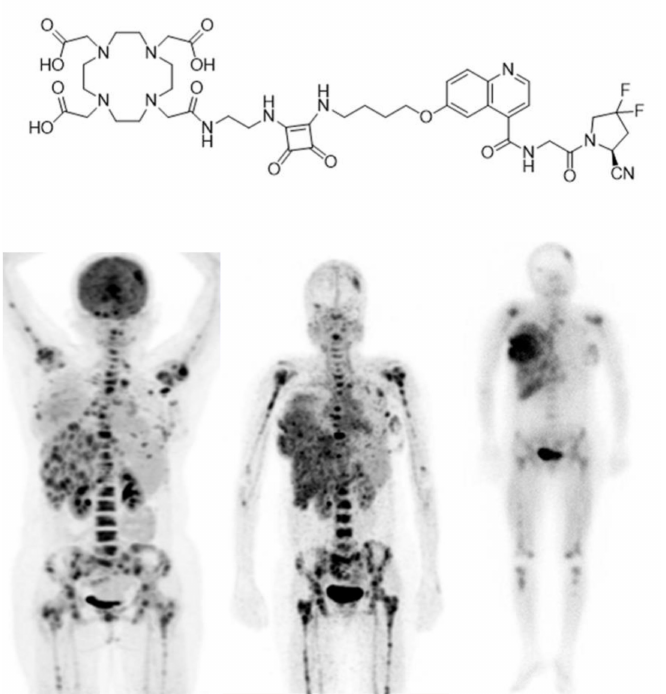
Figure 4. Chemical structure of DOTA.SA.FAPI. PET-Scan of [ 18 F]FDG (left), [ 68 Ga]Ga- DOTA.SA.FAPI (middle) and [ 177 Lu]Lu- DOTA.SA.FAPI (right) of a patient with HER2-positive, (ER and PR)-negative histopathology (Figure adapted from Ballal et al. [109] Creative Commons Attribution 4.0 International